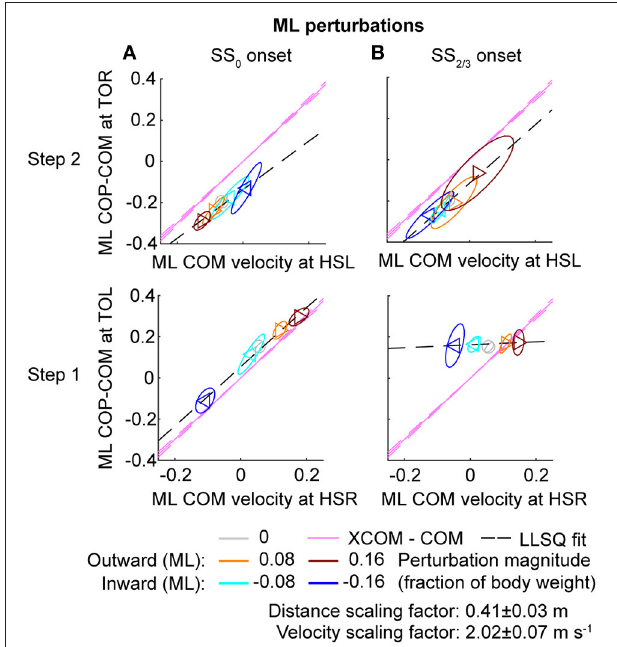
FIGURE 8 | Relation COM velocity and COP location in comparison with the XCOM, following ML perturbations. (A) The ML COP location relative to the COM, at TOL (step 1) and TOR (step 2) as a function of the ML COM velocity at the preceding heel strike. Perturbation onset was at SS 0 . (B) Same as (A) , but for perturbation onset at SS 2 / 3 . The pink line corresponds to the XCOM position relative to the COM, as a function of the COM velocity. It has slope ω − 1 0 and zero intercept. The pink dashed lines indicate the between-subject standard deviation of the XCOM, based on the differences in leg length between subjects. The black dashed line is a linear least squares fit to the data. Triangles show subject-averages and indicate the perturbation direction. Ellipses represent the subject-standard deviation. Colors indicate the different perturbation magnitudes. Data is shown dimensionless.